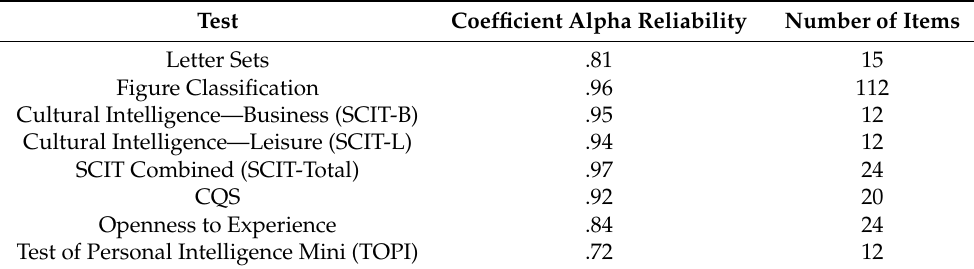
Table 4. Internal Consistency Reliabilities (Coefficient